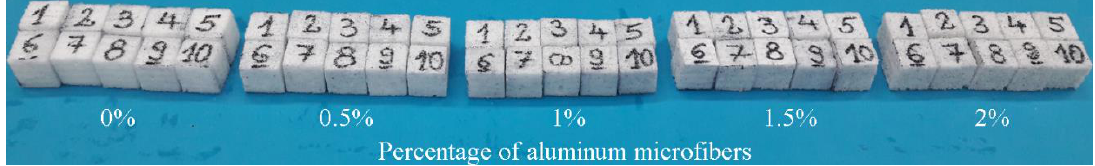
Figure 3. Semi-rigid PU foam blocks obtained depending on the percentage of AMs.